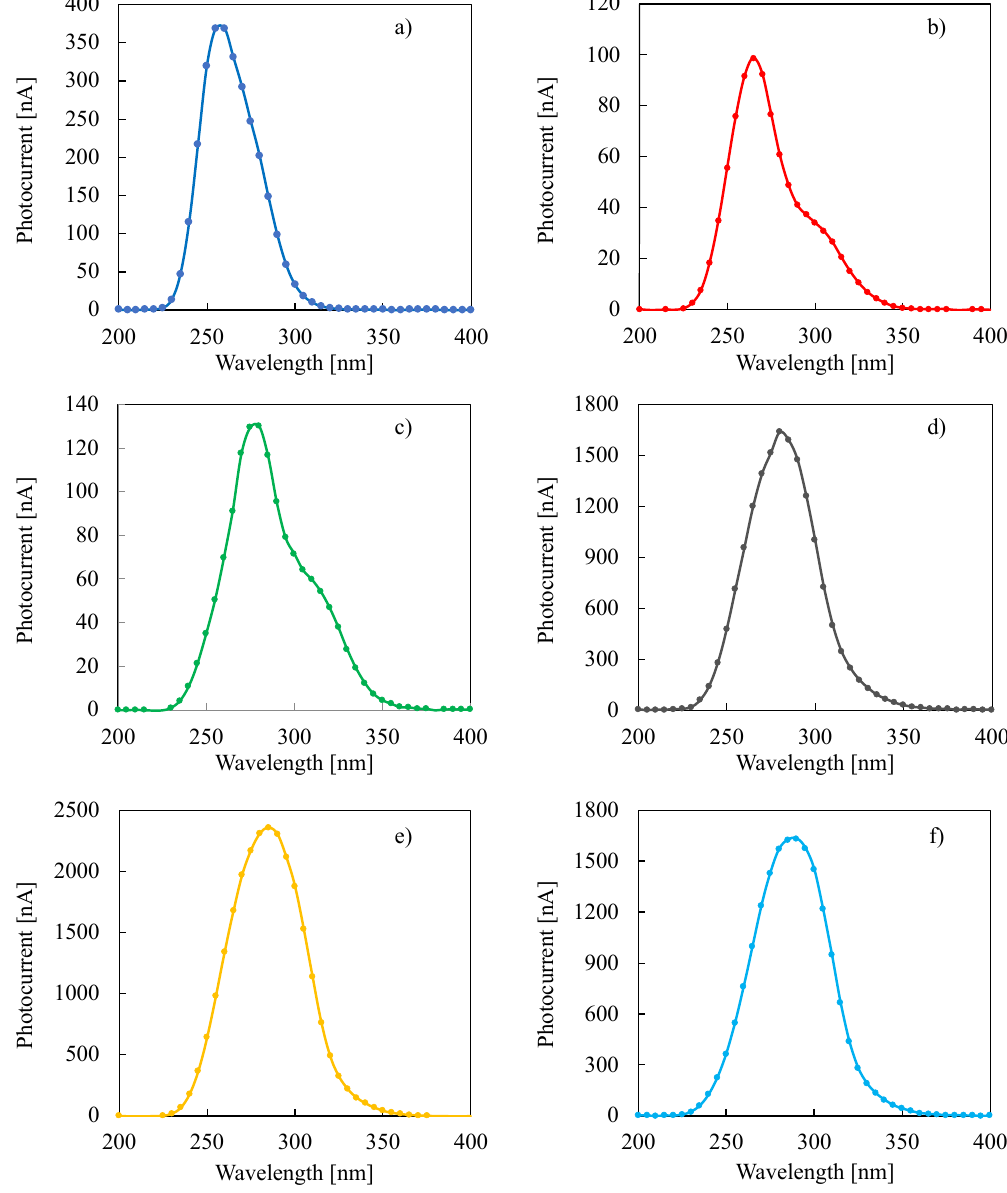
Figure 1. Photocurrent spectra relating to anodic films grown up to 50 V vs. cathode in ABS on ( a ) Ta, ( b ) Ta-19at% Nb, ( c ) Ta-39at% Nb, ( d ) Ta-66at% Nb, ( e ) Ta-85at% Nb and ( f ) Nb, recorded at 8 V vs. Ag/AgCl in 0.1 M ABE.